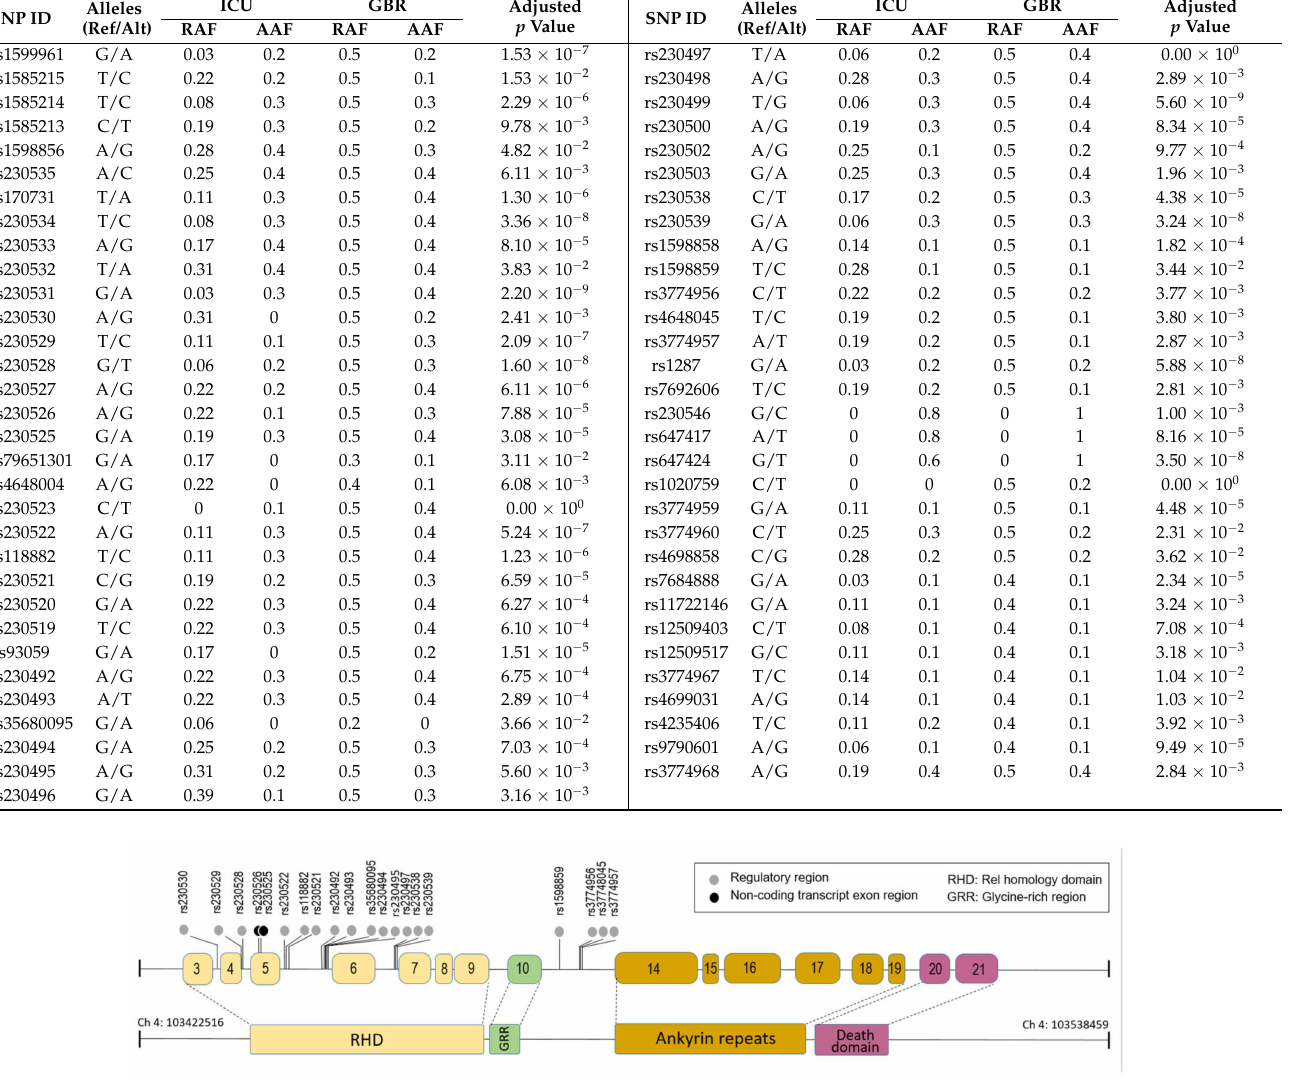
Figure 1. SNP spatial distribution. Schematic representation of the spatial locations of regulatory region SNPs and non- transcript exon SNPs. Top image represents the full NF κ B1 gene map with locations of regulatory region SNPs and non-transcript exon SNPs indicated. The bottom image represents the protein-coding map, consisting of RHD, GRR, Ankyrin Repeats, and the Death